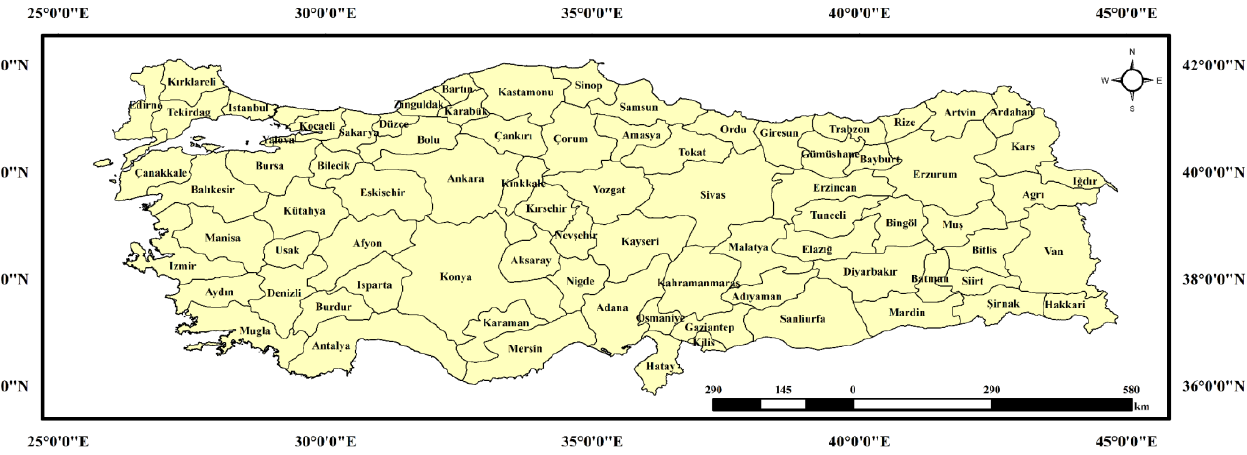
Figure 2. The location of weather stations within the study area (81 provinces of Türkiye).